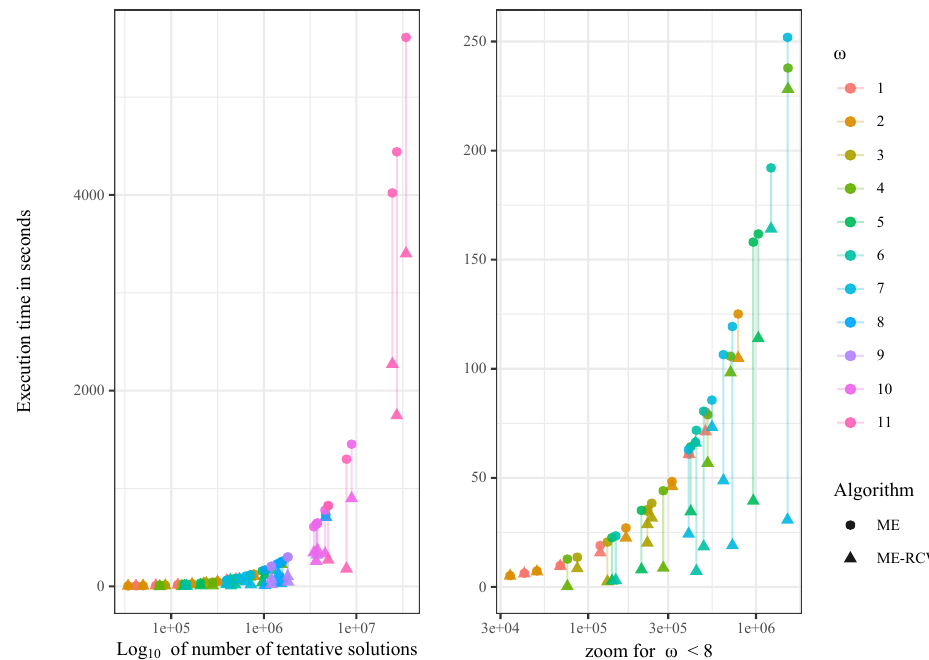
Figure 4. Reduction of the execution time with ME-RCW for profiles of rankings of n = 12 that do not have a Condorcet winner. Each plot shows the execution time in the y-axis and the log transformation of the number of tentative solutions explored in the x-axis. Each line represents, for one profile of rankings, the reduction time of the algorithm ME-RCW in relation to ME . Lines are colored according to the value of ω of the